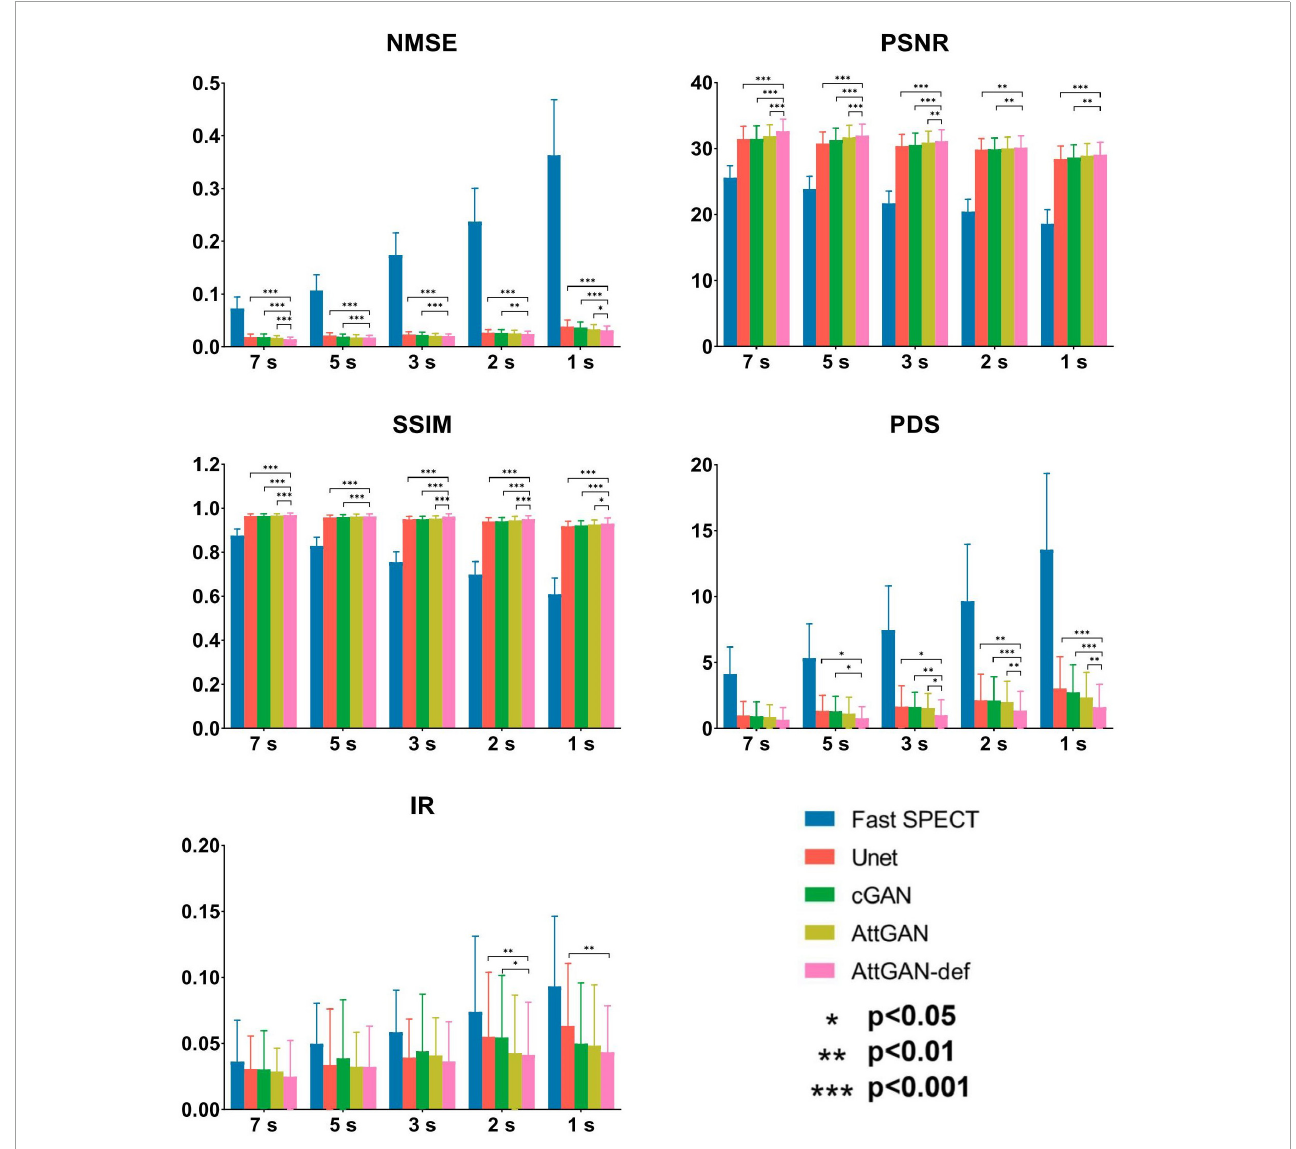
FIGURE6 Quantitative comparison of NMSE, PSNR, SSIM, PDS, and IR on 50 testing datasets for fast SPECT and different denoised images for five shorter acquisition times. Error bars indicate the standard deviation. The filtered FT SPECT images were used as reference. * p <0.05, ** p <0.01, *** p